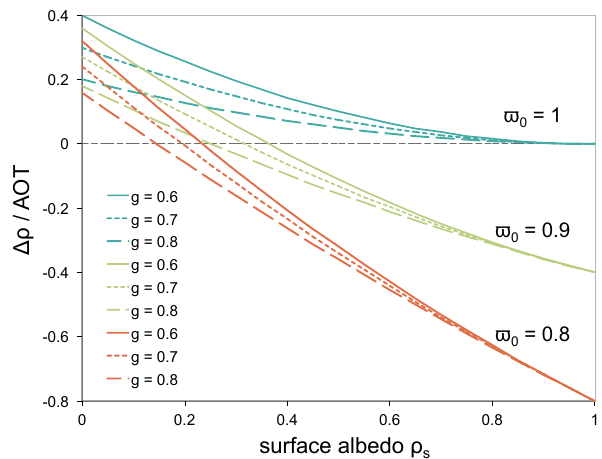
Figure 1. Modification of the albedo at the top of the atmosphere (cid:49)ρ caused by the presence of an aerosol layer versus the albedo of the surface underneath ρ s calculated with the approximate ex- pression given by Lenoble et al. (1982). Darker green lines corre- spond to purely scattering-only aerosols ( (cid:36) 0 = 1), lighter green to aerosols moderately absorbing ( (cid:36) 0 = 0.9), orange lines are for ab- sorbing aerosols ( (cid:36) 0 = 0.8) and g is the asymmetry factor.